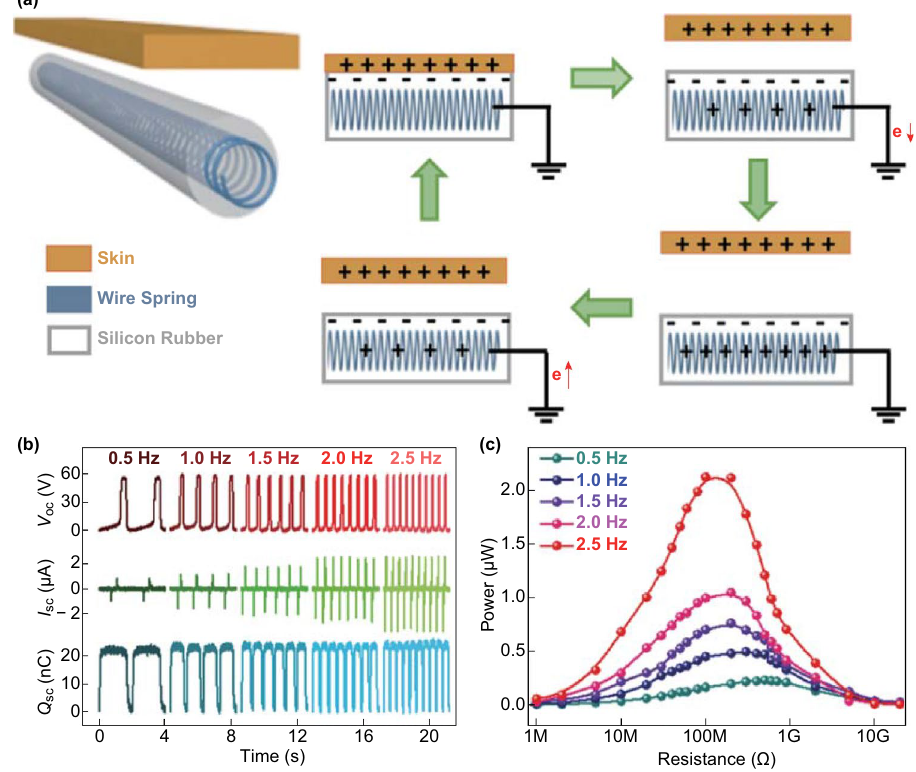
Fig. 2 Working mechanism and electrical output performance of FST‑TENG at single‑electrode mode. a Schematic illustration of working mechanism for generating electricity under short‑circuit conditions. b Electrical outputs of the spiral steel wire based TENG with different motion frequencies ranging from 0.5 to 2.5 Hz, including V oc , I sc , and Q sc . c Dependence of the output average power under external load with different frequencies from 0.5 to 2.5